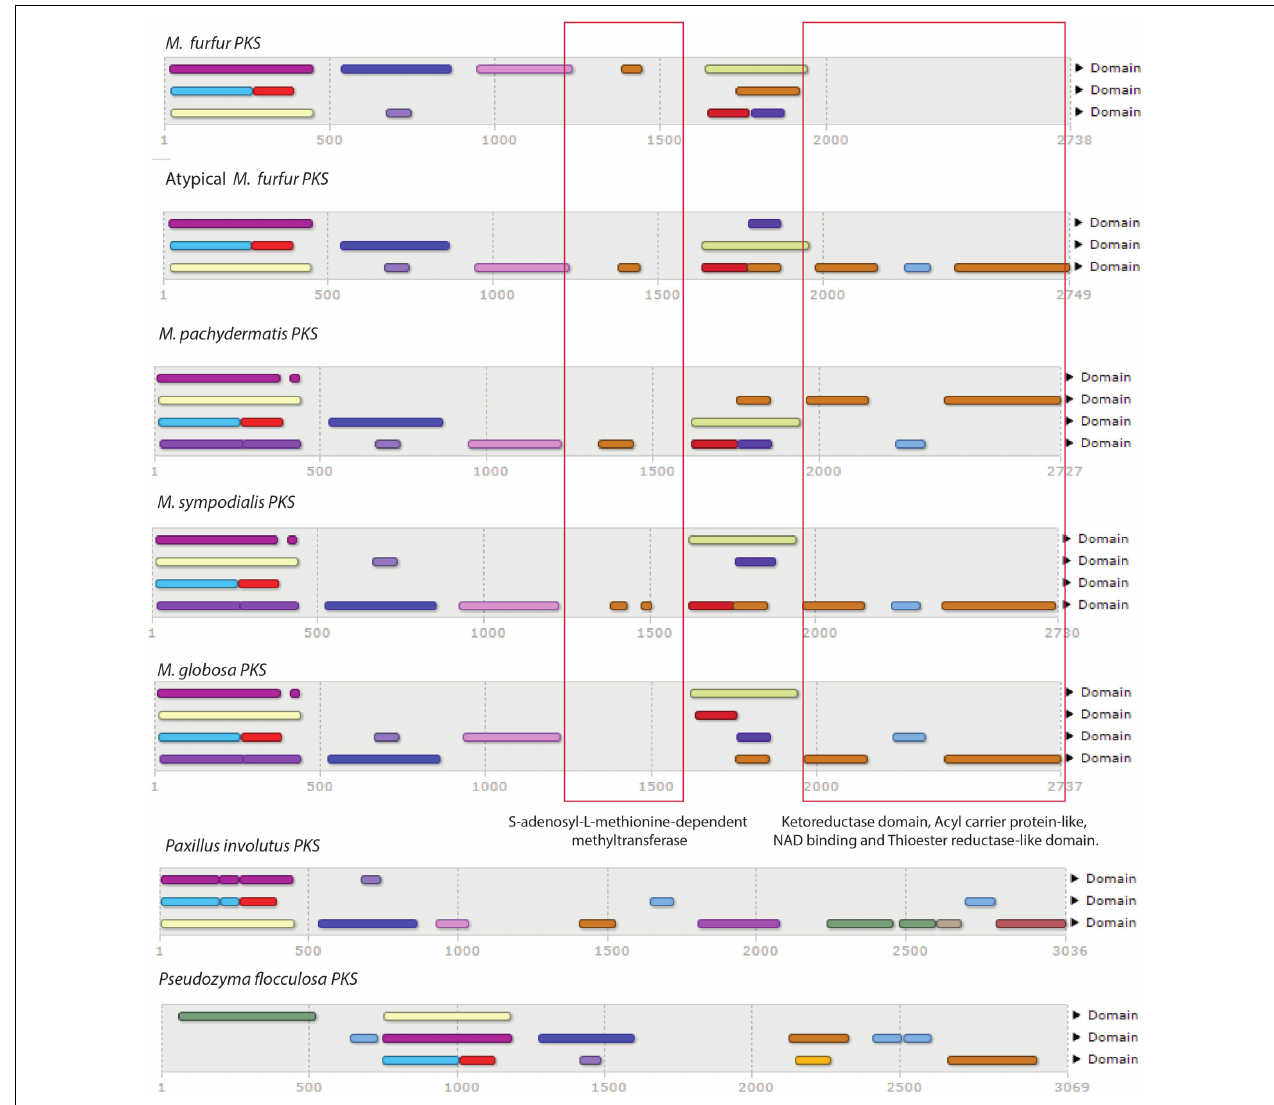
FIGURE 3 | Domains obtained with InterProScan (Quevillon et al., 2005) of the five polyketide synthases (PKSs) of Malassezia species compared with Paxillus involutus and Pseudozyma flocculosa